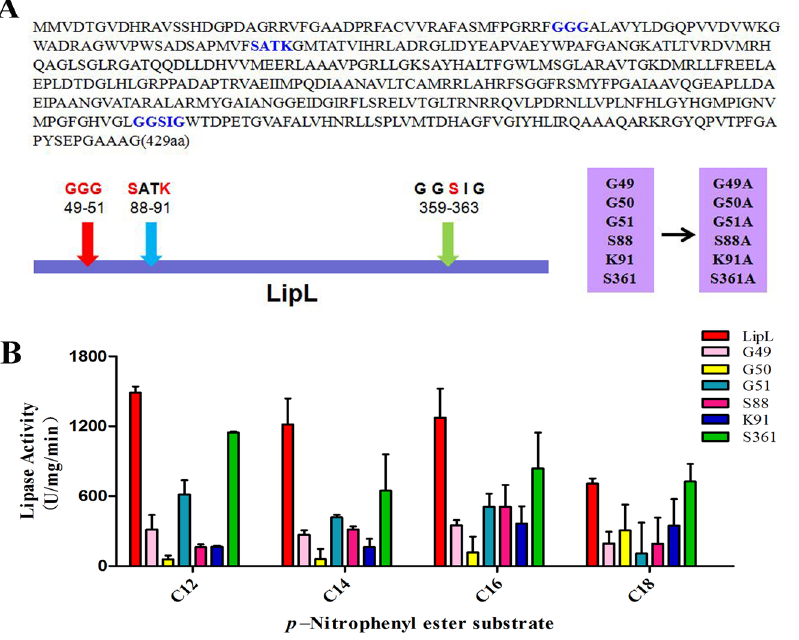
Fig 3. The analysis of the lipase activities of the mutants. The six residue substitutions of site-directed mutagenesis were G49A, G50A, G51A, S88A, K91A, and S361A. (A) A schematic of the LipL protein sequence with predicted catalytic motif and the mutations. (B) The experiment was performed in the standard lipase activity assays. The values represent the means ± SD of three independent experiments.